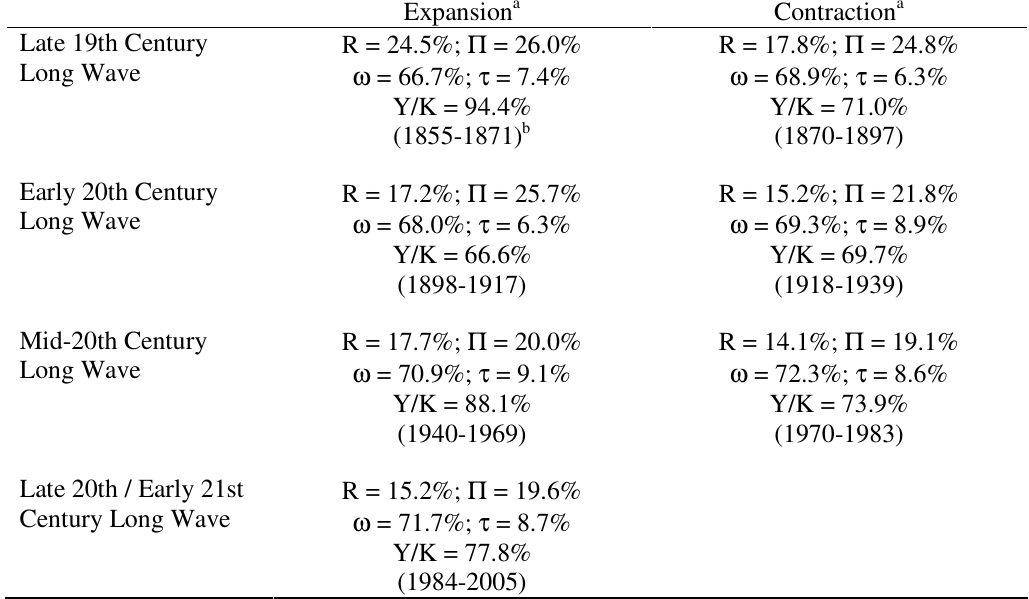
Table 4. The “World I” Profit Rate, Profit Share, and Output-Capital Ratio Expansion a Contraction